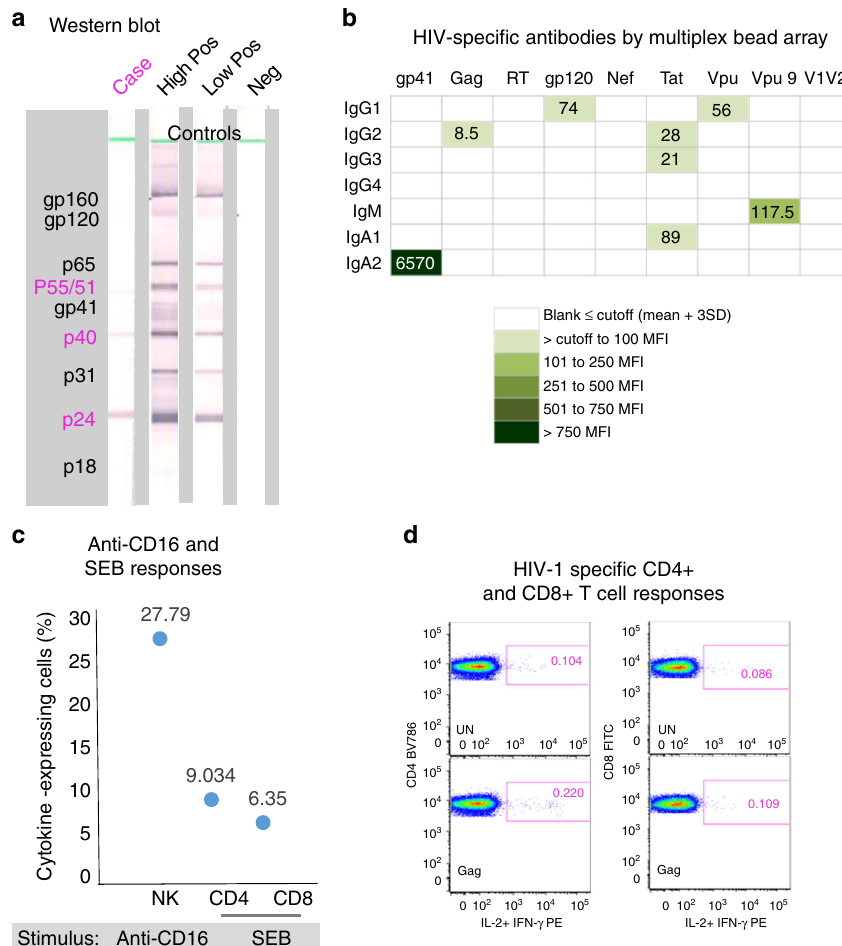
Fig. 3 HIV-speci fi c responses and immune response capability of the case at 9.5 years of age. a Detection of HIV-speci fi c antibodies at 9.5 years of age by western blot. The case antibody pro fi le is compared with controls that are a high positive, low positive and HIV-negative. HIV proteins corresponding to bands in the blots are shown in the left grey-shaded block; the case pro fi le was positive for the core proteins indicated in pink. b Quantitation of HIV- speci fi c antibodies by multiplex bead array for all isotypes and subclasses (indicated on the left side — IgG1, IgG2, IgG3, IgG4, IgM, IgA1, IgA2) against gp41, Gag, RT, gp120, Nef, Tat, Vpu, peptide Vpu9 and V1V2 scaffold antigens (indicated at the top). Results are expressed as mean fl uorescence intensities (MFI)), the colour key shows ranges of MFI according to colour intensity (the darker the more HIV-speci fi c antibody detected). A result is considered positive if above the cut-off (mean ± 3 SD) determined from eight adult uninfected controls. Vpu9 amino acid sequence: STMVDMGHLRLLDVNDL. c Proportions of natural killer (NK) cells that respond to anti-CD16 antibody, and CD4 + and CD8 + T cells that respond to staphylococcal enterotoxin B (SEB) in a whole blood intracellular cytokine (ICC) assay that measures induction of interferon- γ (IFN- γ ) and interleukin-2 (IL-2). HIV-uninfected adult reference values for comparison ( n = 21; median % and range) — natural killer (NK) anti-CD16%: 37.92 (12 – 67.6), CD4 SEB%: 6.04 (0.25 – 11.91), CD8 SEB%: 5.82 (0.18 – 18.94). d A weak positive CD4 + T cell response to Gag (0.116%) in the absence of a detectable CD8 + T cell response to Gag (<0.1%; 0.023%). UN: addition of costimulatory antibodies anti-CD28 and anti-CD49d, no stimulation with